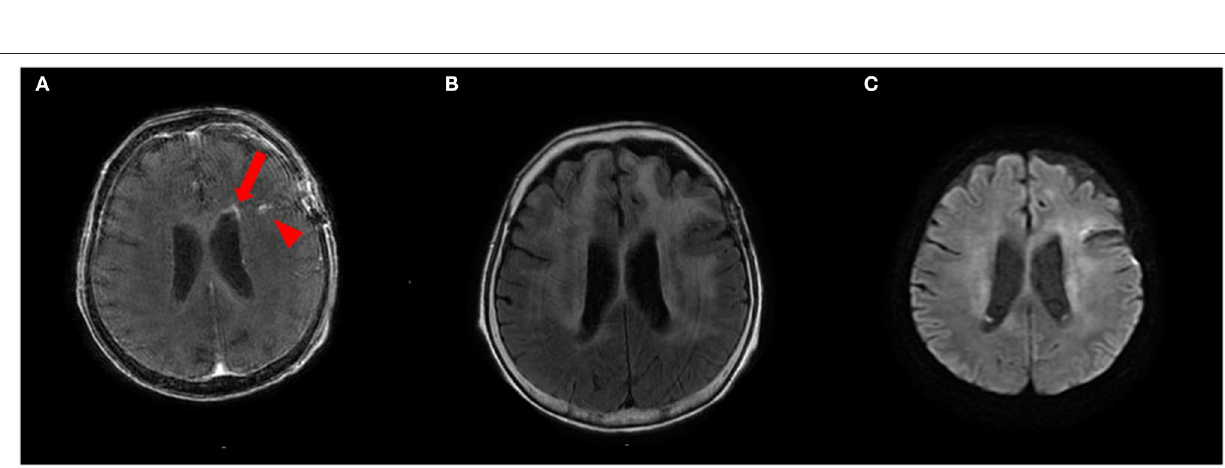
FIGURE 4 | (A,B) Contrast-enhanced brain MRI recorded 1 month after brain biopsy shows a spotty gadolinium enhancement in the left periventricular white matter ( arrow ) and post-biopsy scar ( arrowhead ) (A) with T2 hyperintensities (B) . (C) This lesion does not show abnormal hyperintensities on diffusion-weighted imaging